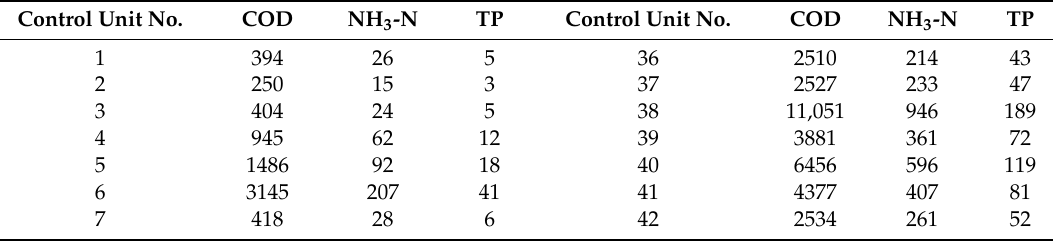
Table 3. Water environment capacity table of the Taihu Basin control units, Jiangsu Province (unit: t / a). Control Unit